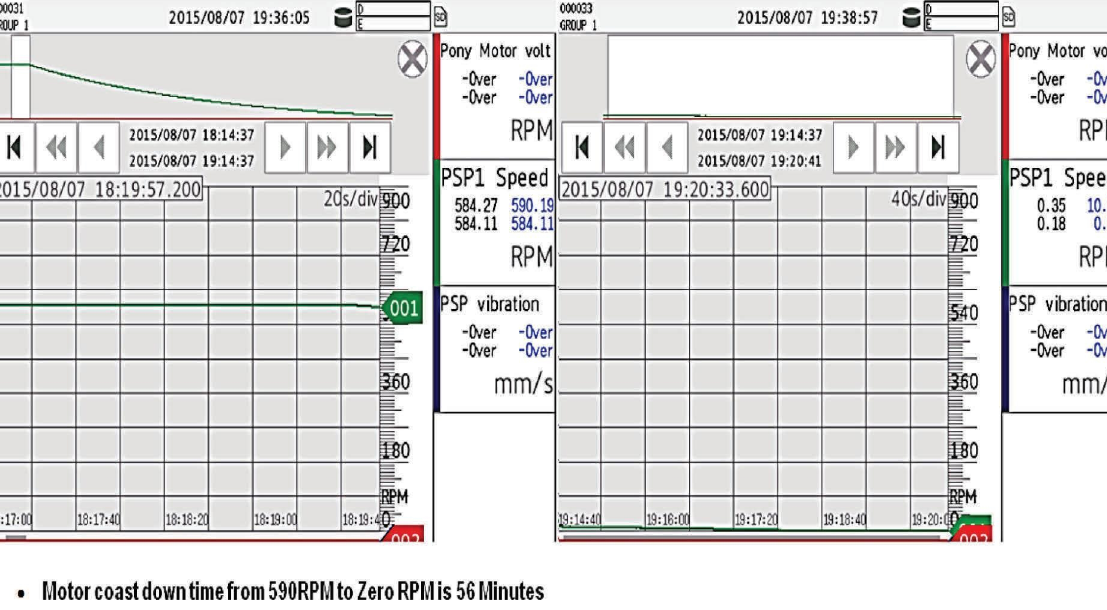
Figure 19: Characteristics of the motor with PI and